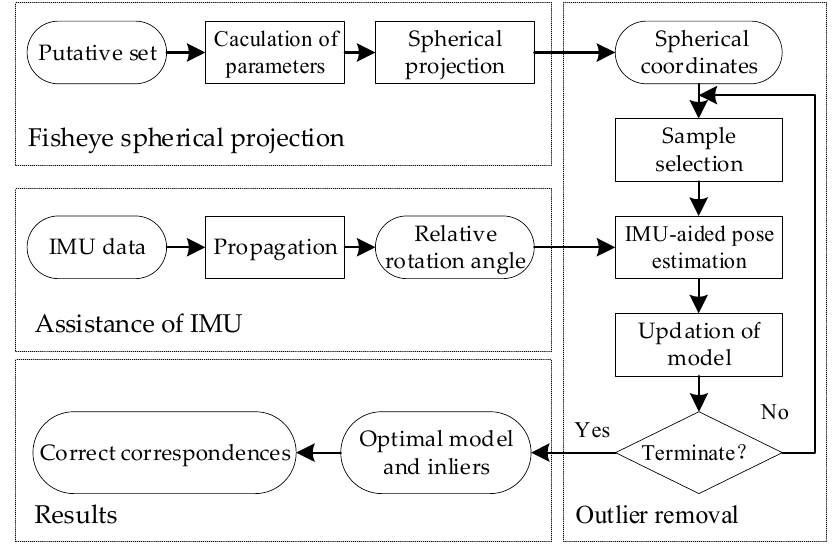
Figure 2. Flowchart of the So-RANSAC.